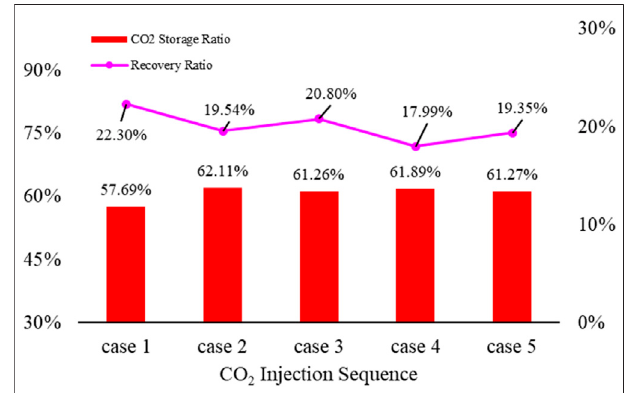
FIGURE 9 | Annual CO 2 storage ratio under different injection sequences. FIGURE 10 | Total CO 2 storage ratio under different injection